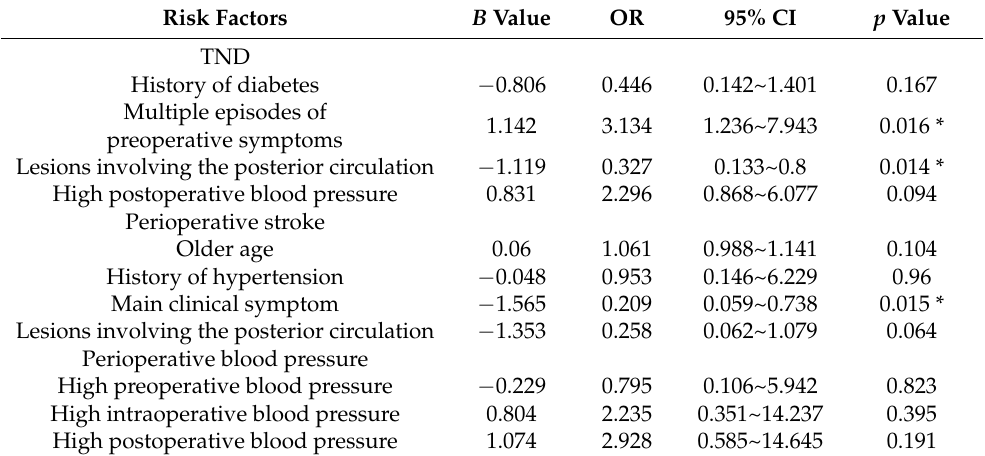
Table 5. The multivariate analysis of perioperative complications after revascularization in 203